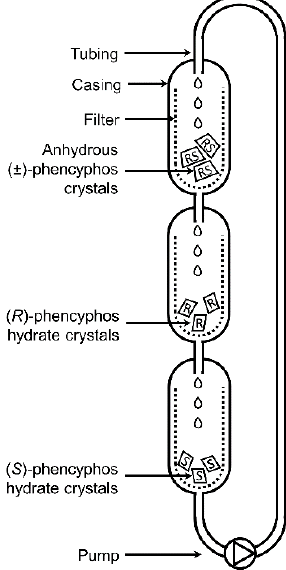
Figure 3. Schematic representation of the practical setup.